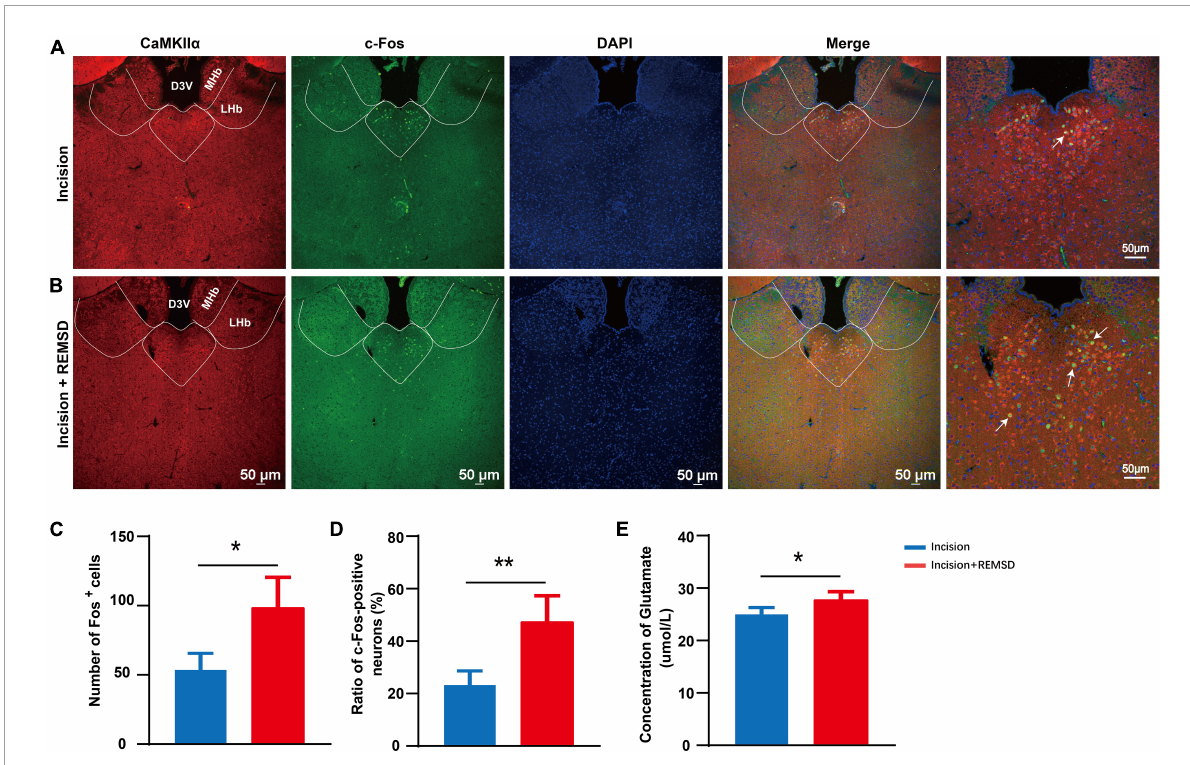
FIGURE2 Rapid eye movement sleep deprivation (REMSD) can significantly increase c-Fos in the CaMKII α + neurons in the middle paraventricular thalamus (mPVT CaMKII α ) at day 7 after surgery. (A) Expression of c-Fos in the mPVT CaMKII α of the incision group. (B) Expression of c-Fos in the mPVT CaMKII α of the incision + REMSD group. The arrows represent CaMKII α neurons colocalize with c-Fos. (C) Quantification of c-Fos expressing neurons in incision and incision + REMSD mice and the counted area of c-Fos + neurons was delineated of mPVT by the broken line. (D) Ratio of c-Fos-positive neurons in the paraventricular thalamus (PVT) after REMSD treatment. The ratio of c-Fos-positive neurons was calculated as follows: (c-Fos/CaMKII α ) *100. (E) Level of glutamate in the PVT after REMSD treatment. Significance was assessed by two-tailed unpaired t -test in panels (C–E) . Incision + REMSD vs. incision; n = 5. * P < 0.05, ** P <